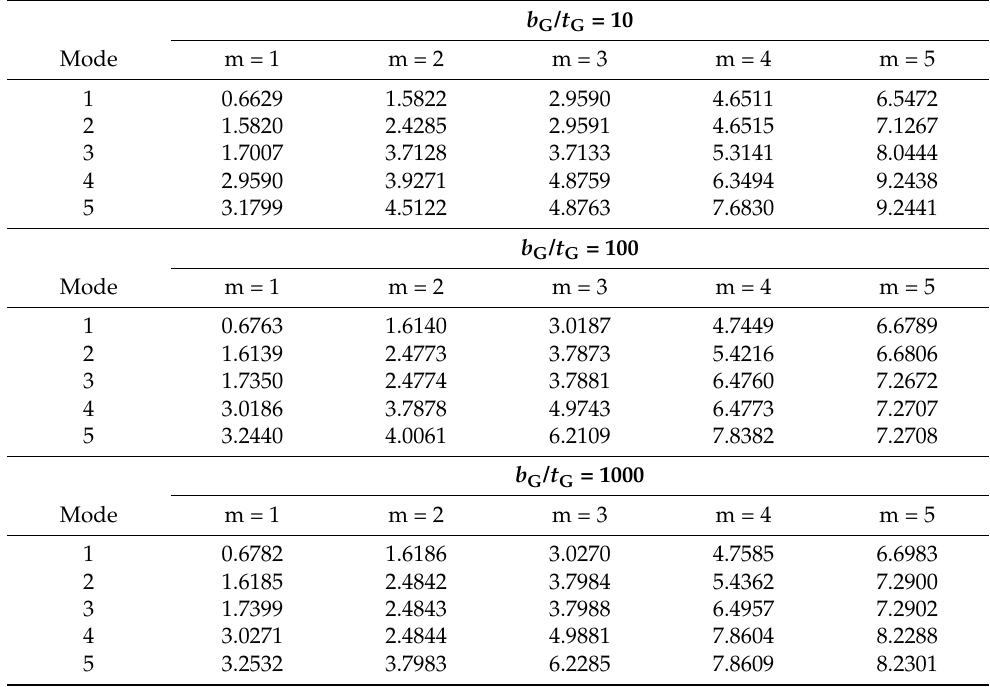
Table 4. Natural frequencies of the SSSS GPLs reinforced PMMA square plates for different GPLs width-to-thickness ratios ( t G = 1.5